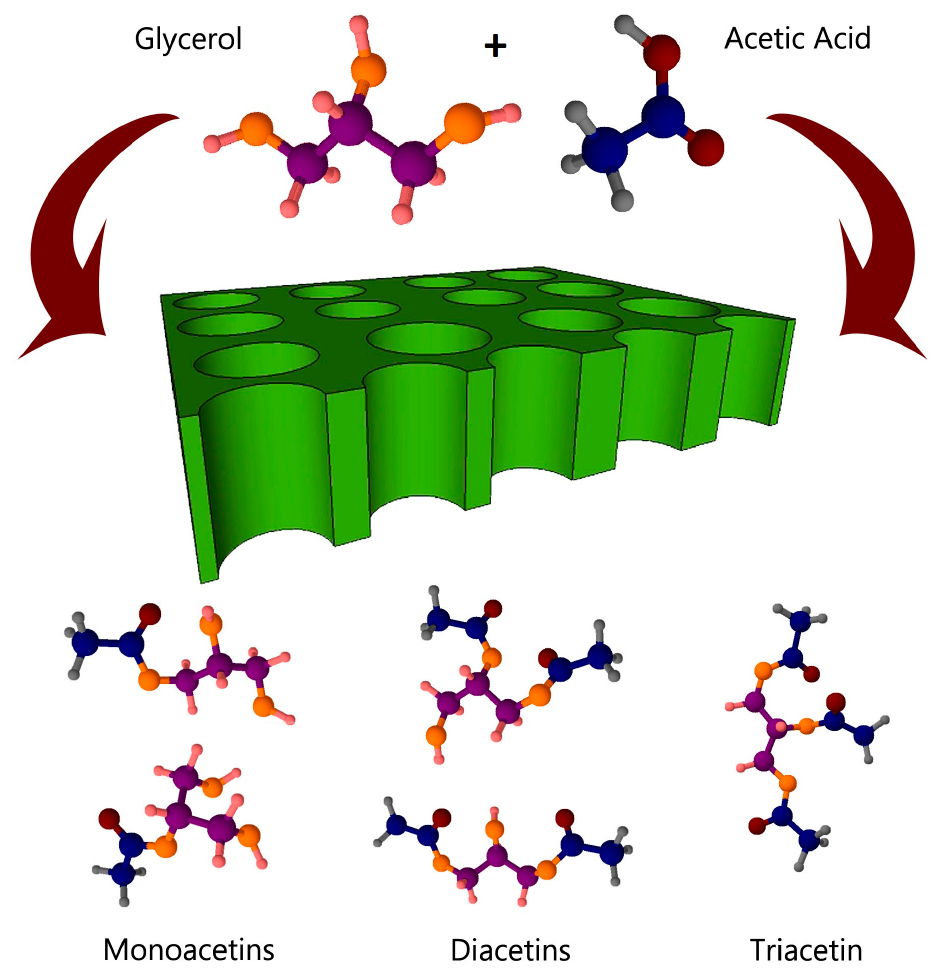
Figure 1. Schematic reaction pathways for acetins production via esterification of glycerol with acetic acid over porous solids.